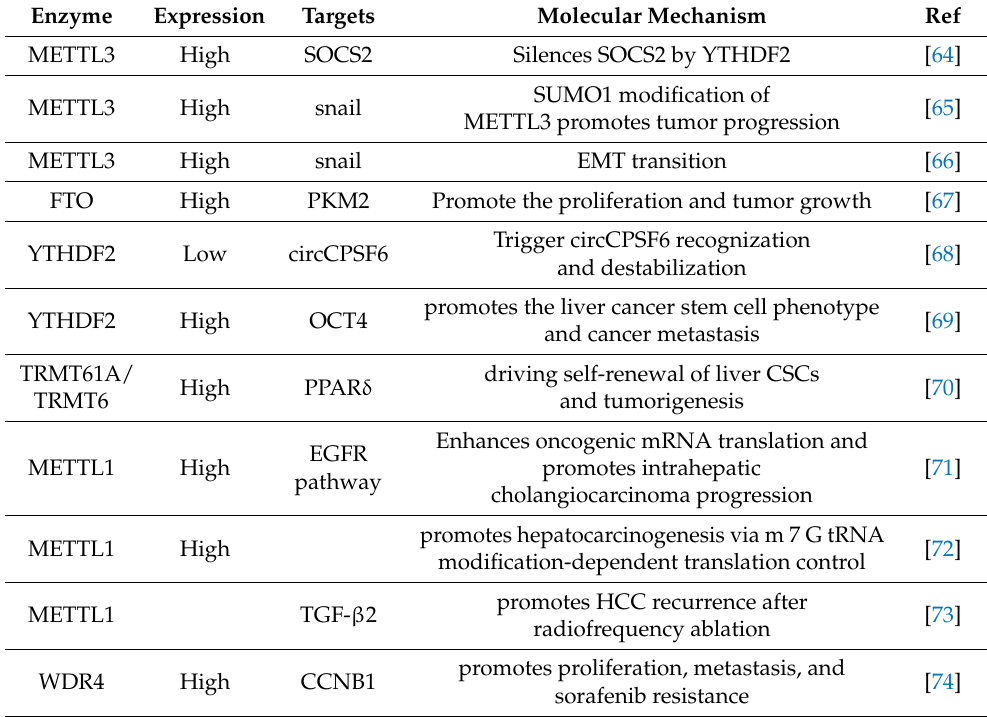
Table 1. RNA modification and liver cancer.